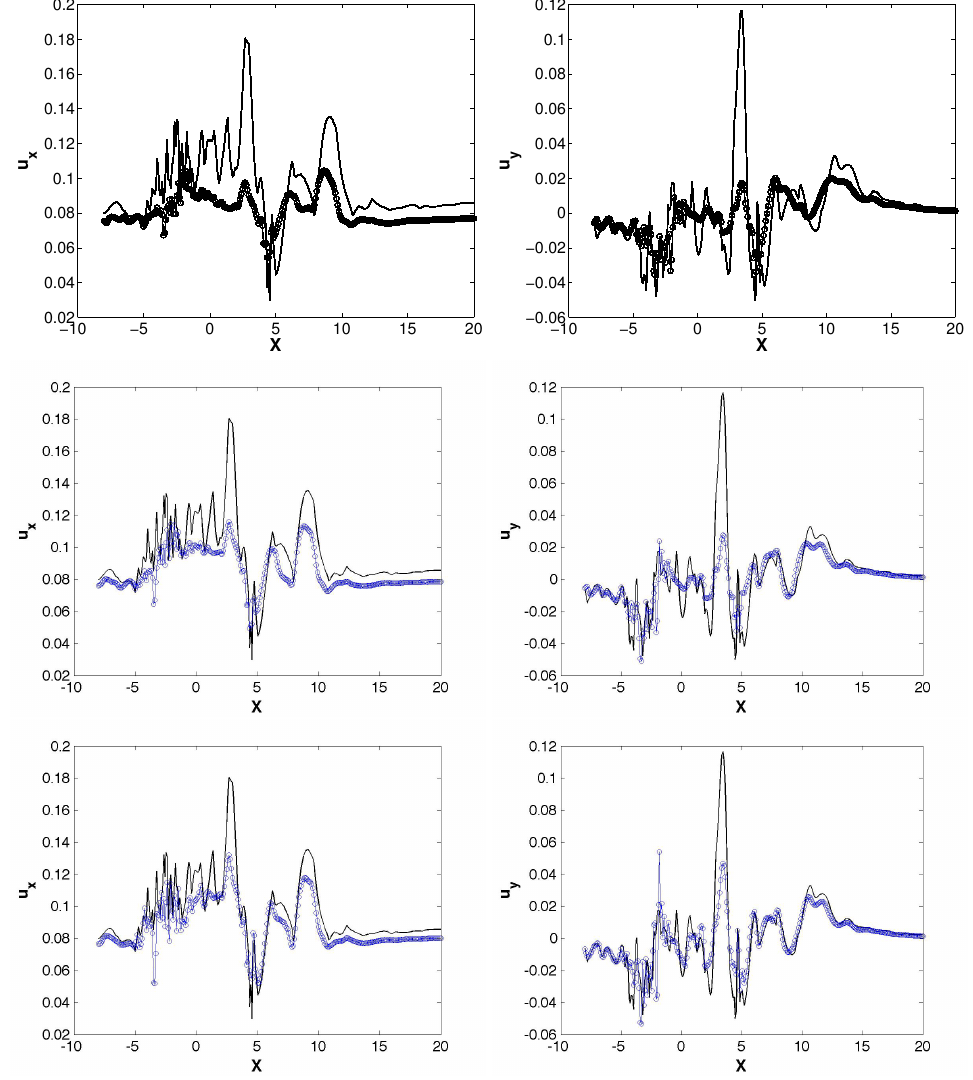
Figure 7. One-blade wind turbine case: temporal evolution of streamwise ( left ) and normal ( right ) velocities in y = − 4 m at time instant 240 s. From top to bottom: HODMD-based ROM constructed using M = 3, 5 and 21 DMD modes. Continuous black line and blue circles represent the original and the predicted solution,